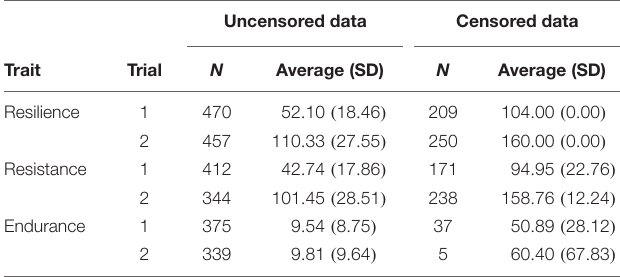
TABLE 2 | Number of data ( N ) and average number of days (standard deviation) for the different